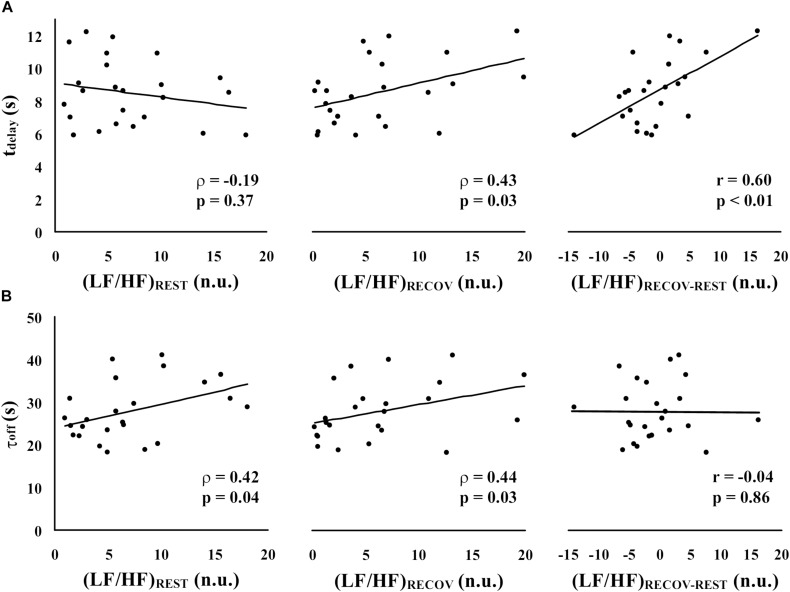
Spearman’s rank correlations (ρ) and Pearson’s partial correlations (r) between each of the HRV-based indicators of sympatho-vagal balance [(LF/HF)REST, (LF/HF)RECOV, and (LF/HF)RECOV–REST] and the parameters characterizing the time-course of HR recovery [tdelay in panel (A), and τoff in panel (B)].